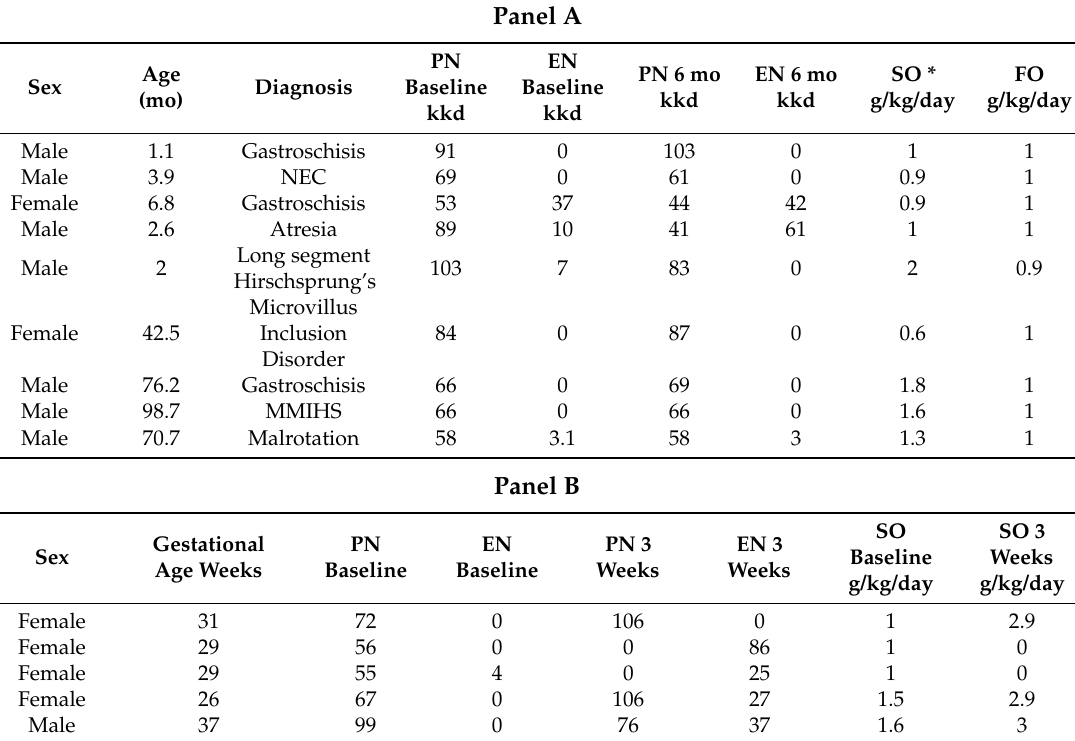
Table 2. Characteristics of children included in study 1 (panel A) and 2 (panel B). Panel